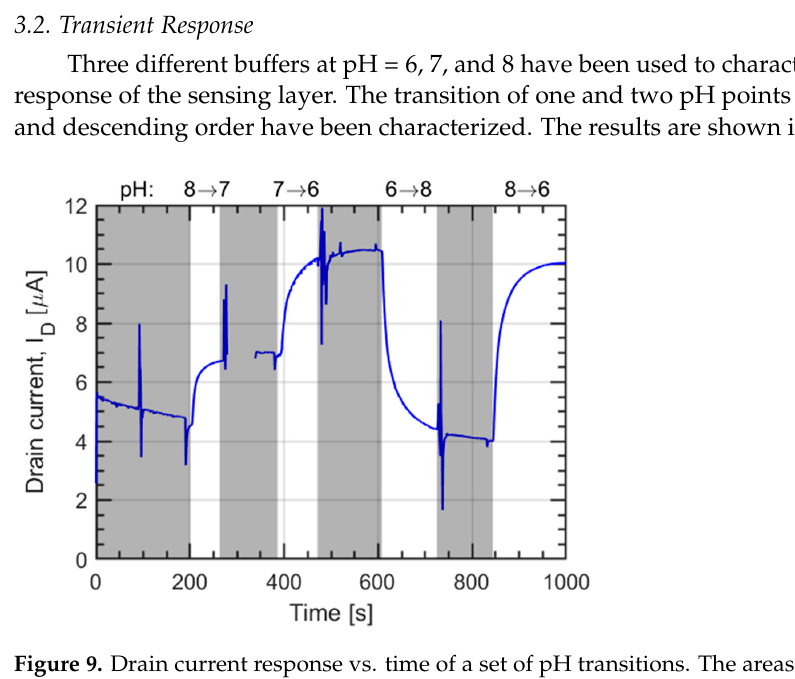
Figure 9. Drain current response vs. time of a set of pH transitions. The areas not relevant for the characterization of the transition have been greyed out.